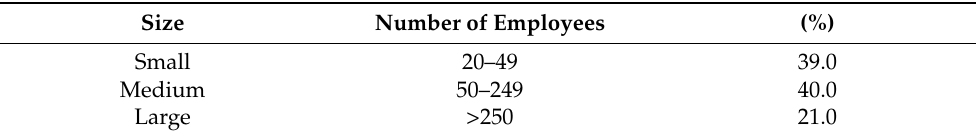
Table 1. Distribution of firms by size.